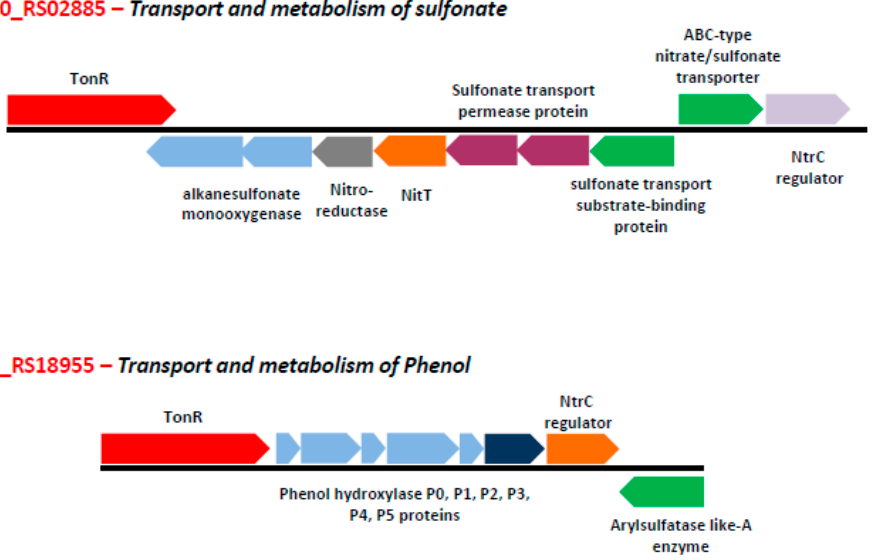
Figure 4. Expression pattern-based phylogenetic tree. Xenobiotic responsive TBDT sequences of Sphingomonas wittichii RW1 (blue), Sphingobium sp . ba1 (dark pink), Sphingopyxis alaskensis RB2256 (red), Sphingomonas sp . SKA58 (orange), and Novosphingobium aromaticivorans DSM 12444 (purple) are included along with 61 uncharacterized Sf TBDTs (black) while constructing the phylogenetic tree.